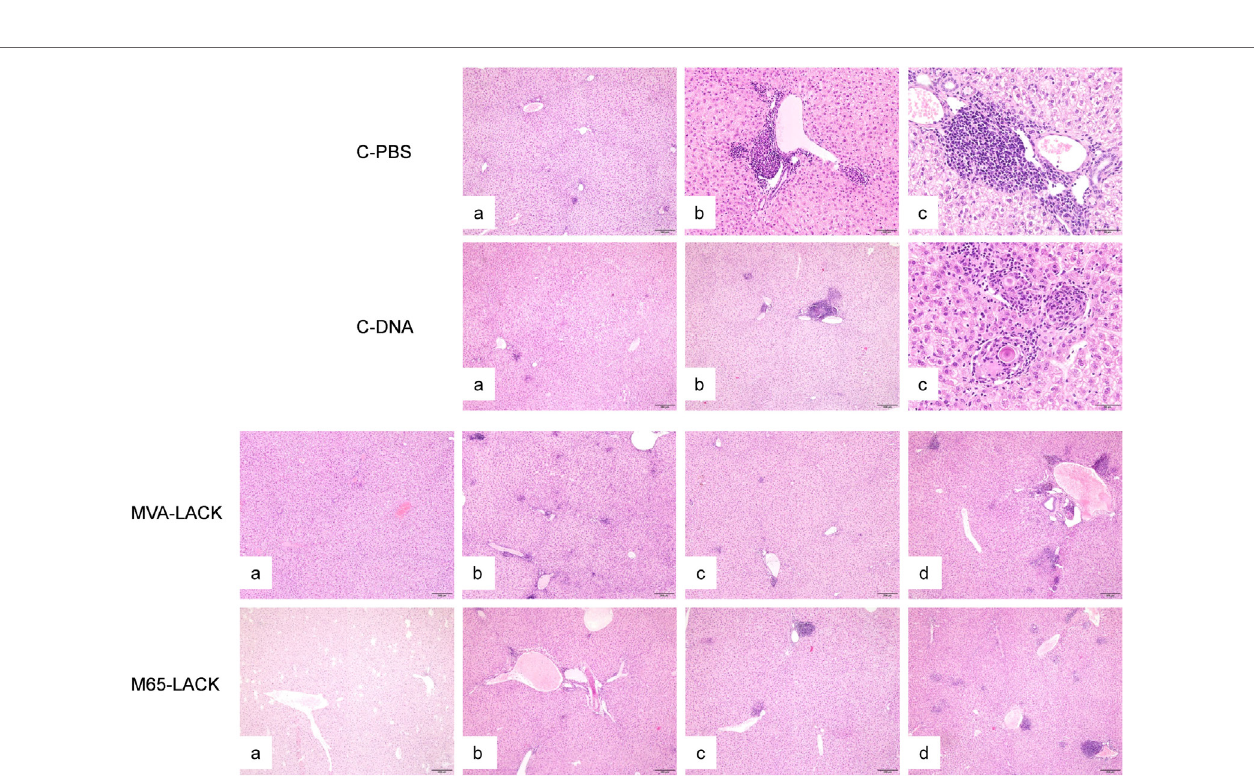
FigUre 4 | Liver histopathology of hamsters in the C-PBS, C-DNA, MVA-LACK, and M65-LACK groups. C-PBS group— mild, multifocal granulomatous hepatitis (a), moderate (b), and severe, multifocal, periportal, granulomatous hepatitis with intralesional Shauman bodies (c). C-DNA group—minimal hepatic inflammation (a), moderate multifocal, periportal granulomatous hepatitis (b), and severe, multifocal to coalescing granulomatous hepatitis with intralesional Shauman bodies (c). MVA-LACK group—minimal hepatic inflammation (a), mild, multifocal granulomatous hepatitis (b), moderate, multifocal, granulomatous hepatitis (c), and severe, multifocal to coalescing granulomatous hepatitis (d). M65-LACK group—minimal hepatic inflammation (a), mild, multifocal granulomatous hepatitis (b), moderate, multifocal granulomatous hepatitis (c), and severe, multifocal to coalescing, periportal, granulomatous hepatitis